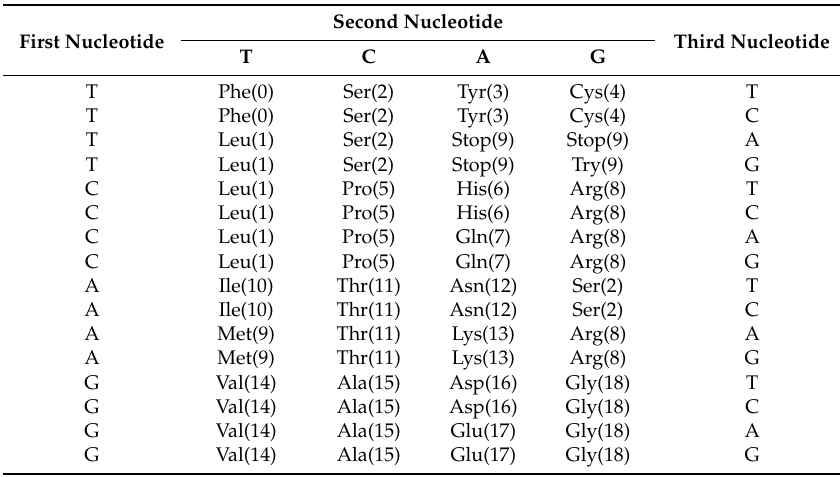
Table 1. Relationship between triplet codons and 19-ary